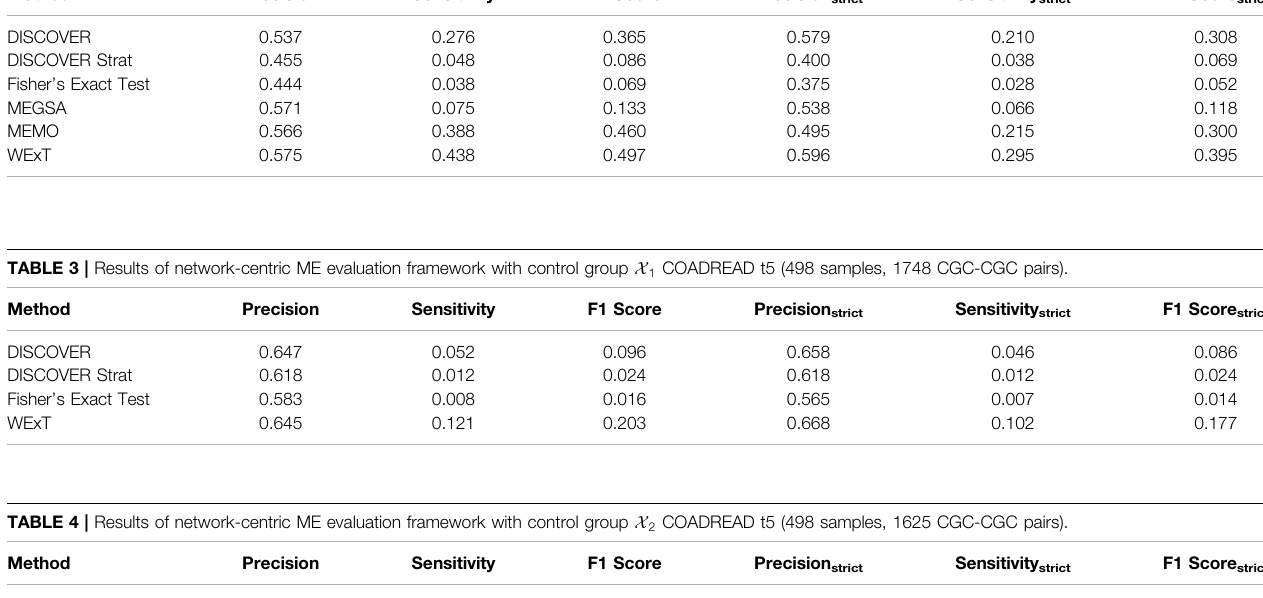
TABLE 2 | Results of network-centric ME evaluation framework with control group X 2 COADREAD t20 (498 samples, 107 CGC-CGC pairs). Method